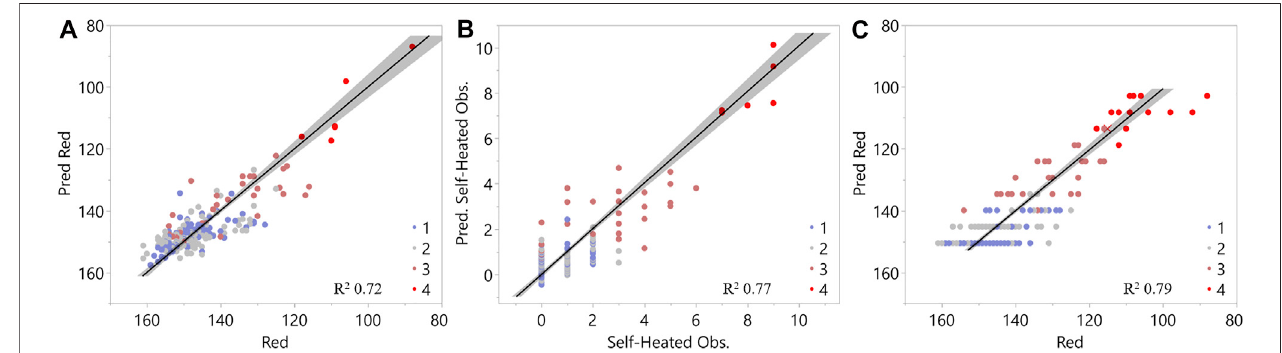
FIGURE 4 | Least squares regression analysis of (A) red band intensity as a function of chemical composition, (B) biological degradation/self-heating observation asafunctionofchemicalcomposition,and (C) redbandintensityasafunctionofbiologicaldegradation/self-heatingobservation.Legendgivesresultsofclusteranalysis from chemical composition in Figures 3A,B .